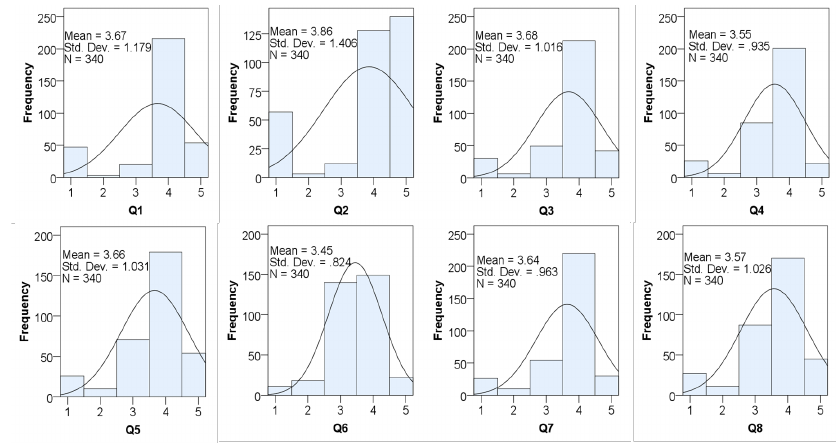
Fig. 6. Histograms of student